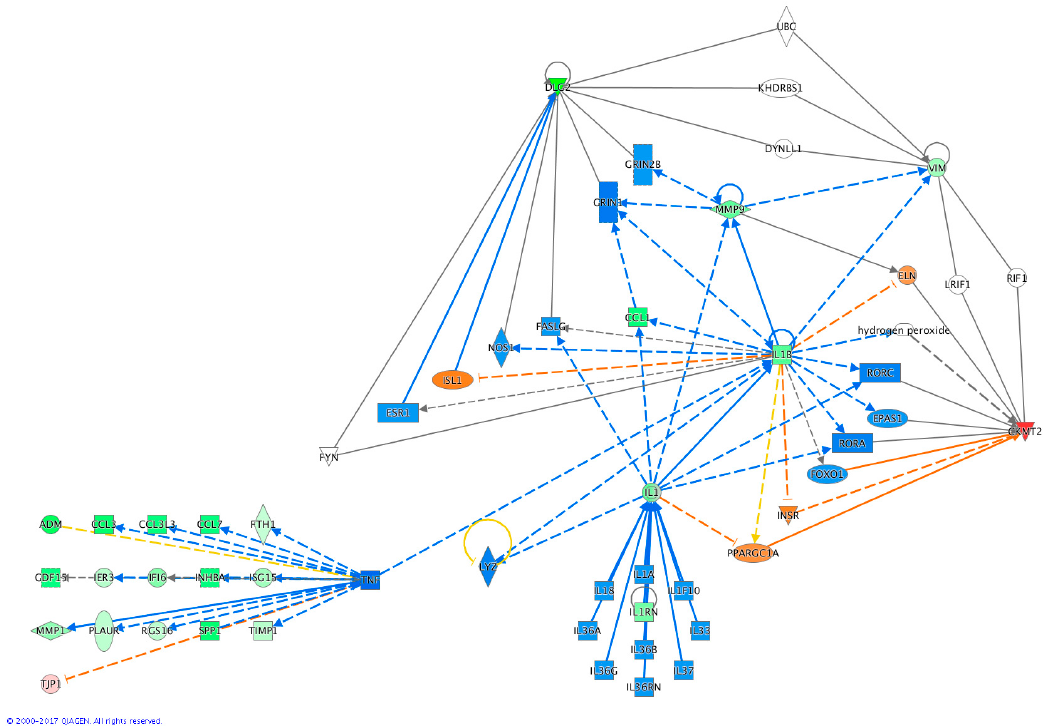
Figure 4. IPA analysis of signalling pathways of the genes differentially expressed upon lysozyme treatment. U937 cells were treated with lysozyme 15 μ g/mL for 1 h and analysed immediately at the end of the treatment (1 h). Down ‐ regulated genes by lysozyme treatment are marked in green, up ‐ regulated genes are marked in red, orange colour indicates the prediction of an activation, blue colour the prediction of an inhibition; continuous line indicates direct relationships, dashed line indicates an indirect relationship (one or more intermediates), yellow colour indicates relationships non ‐ consistent with the state of the down ‐ stream molecule, grey colour indicates an unpredicted effect.